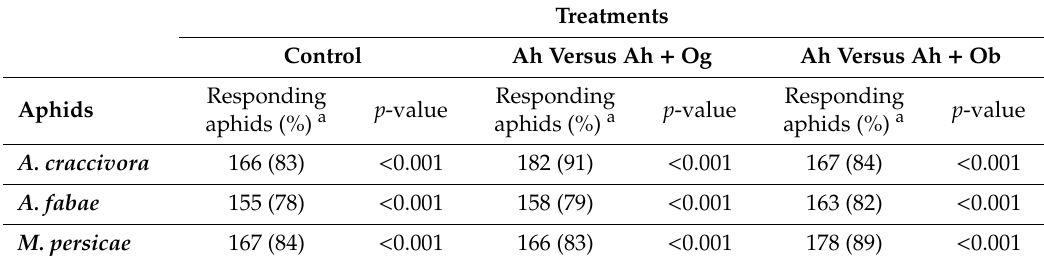
Table 2. Responding aphids in choice test according to treatment. Control: Ah versus Ah, Ah: A. hybridus , Og: O. gratissimum , Ob: O. basilicum.